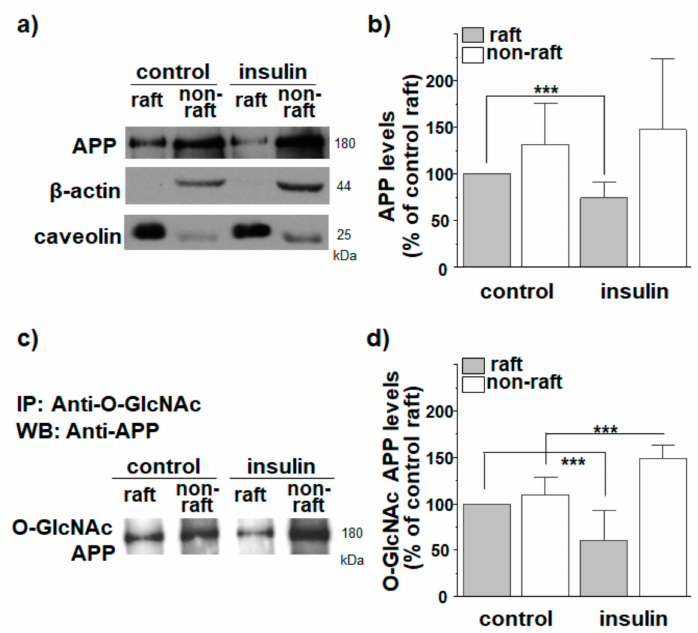
Figure 2. O-GlcNAcylation in response to insulin translocates APP from lipid raft to non-raft frac- tions. SH-SY5Y-APP/BACE1 cells were incubated with insulin for 2 h. Cells were then harvested, homogenized, and sonicated. Equal amounts of proteins from cell lysates were loaded on discon- tinuous sucrose density gradients as described in the Methods section to obtain 12 fractions. We combined fractions 4 to 6 (lipid raft fractions) or fractions 8 to 12 (non-raft fractions). ( a , b ) Equal amounts of proteins from lipid raft and non-raft fractions were loaded for Western blots to detect APP ( n = 7, number of independent experiments). APP levels were compared to APP level in raft fraction of control cells. ( c , d ) Lipid raft and non-raft fractions were immunoprecipitated with O-GlcNAc anti- body, and then probed with APP antibody ( n = 7, number of independent experiments). O-GlcNAc APP levels were compared to O-GlcNAc APP levels in raft fractions of control cells. Caveolin was used as a lipid raft marker. One-way ANOVA: ***, p < 0.001. All values represent mean ±